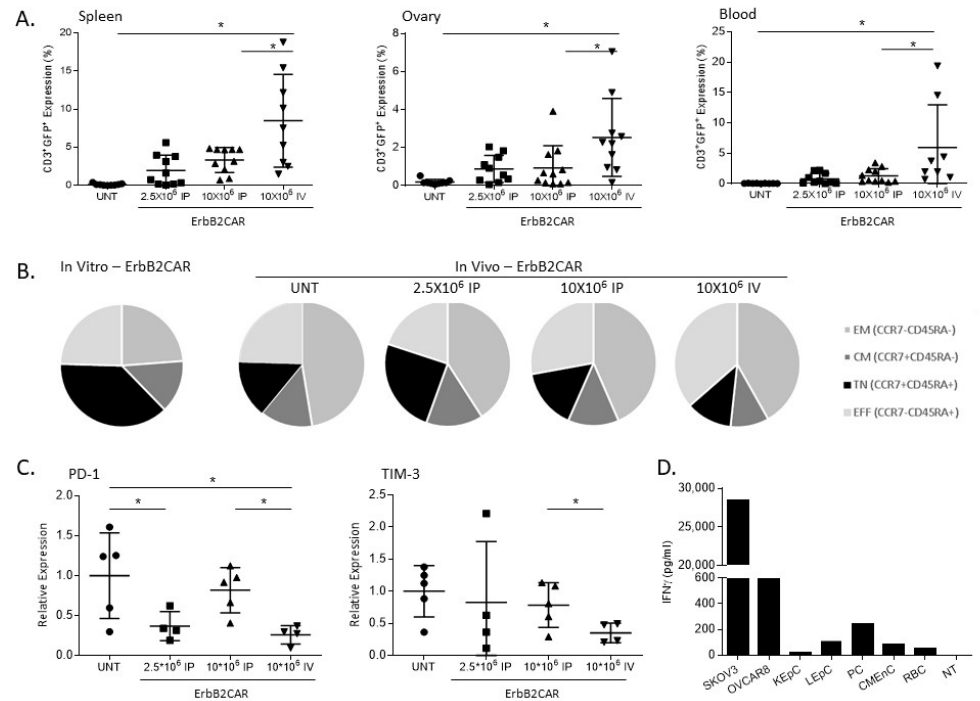
Figure 3. In vivo persistence and safety analysis of ErbB2CAR-T cells. ( A ) The mice were injected with 2 × 10 6 cells IP NAR-LUC cells. After 20 days, they were treated with ErbB2CAR (2.5 × 10 6 IP or 10 × 10 6 IP or 10 × 10 6 IV cells), UNT, or were left untreated. They were euthanized after 45 days. Cells from the spleen, ovary, and blood were collected and stained with anti-human CD3 and analyzed by flow cytometry. Each group included an average of 8–11 mice ± SEM. Data were analyzed by one-way ANOVA test * p < 0.05. ( B ) The leftmost pie diagram depicts the percentage of CCR7 and/or CD45RA expression out of CD3/ErbB2CAR-GFP-positive T cells (average of four independent transductions). The mice were then euthanized 45 days post-NAR-LUC injection. Splenic single-cell suspension was prepared and stained with anti-human CD3/CCR7/CD45RA and analyzed by flow cytometry. The three right pies depict the percentage of CCR7 and/or CD45RA expression out of CD3-positive cells. EM—effector memory cells, CM—central memory, TN—naïve T cells, and EFF—effector T cells. Each group included an average of 5–11 mice. ( C ) The mice were euthanized 45 days post-NAR-LUC inoculation, and RNA levels from the splenic cells were measured for PD-1 and TIM-3. The relative expressions were normalized to the housekeeping gene GAPDH, and UNT-treated mice were considered as 1. Each group included an average of 4–5 mice ± SEM. Data were analyzed by 1-way ANOVA test * p < 0.05. ( D ) Primary cells from different tissues of healthy human donors were co-cultured with lymphocyte T cells transduced for 24 h with ErbB2CAR at an E:T ratio of 2:1. Supernatants were collected and secreted IFN γ was measured by ELISA. The